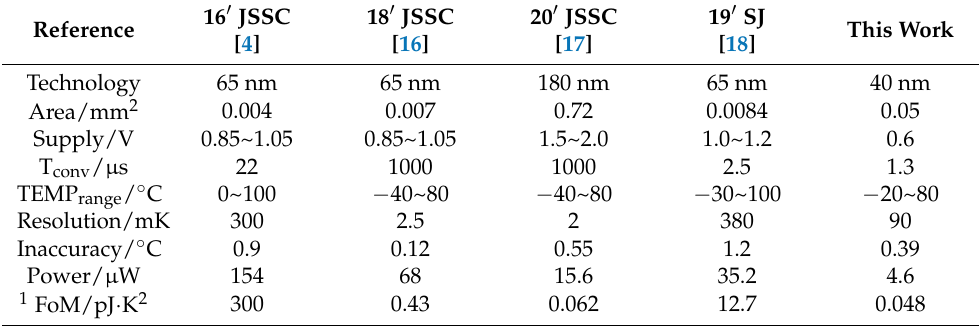
Table 1. Performance comparison of the proposed sensor with state-of-the-art works.